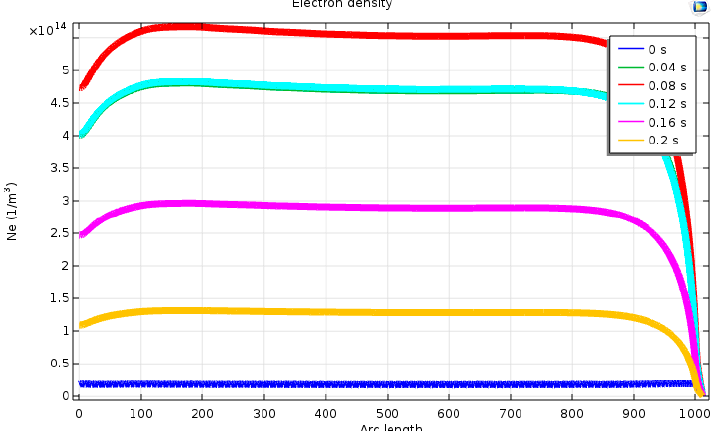
Figure 7. Electron density distribution along the ignition line at key time nodes during the discharge.